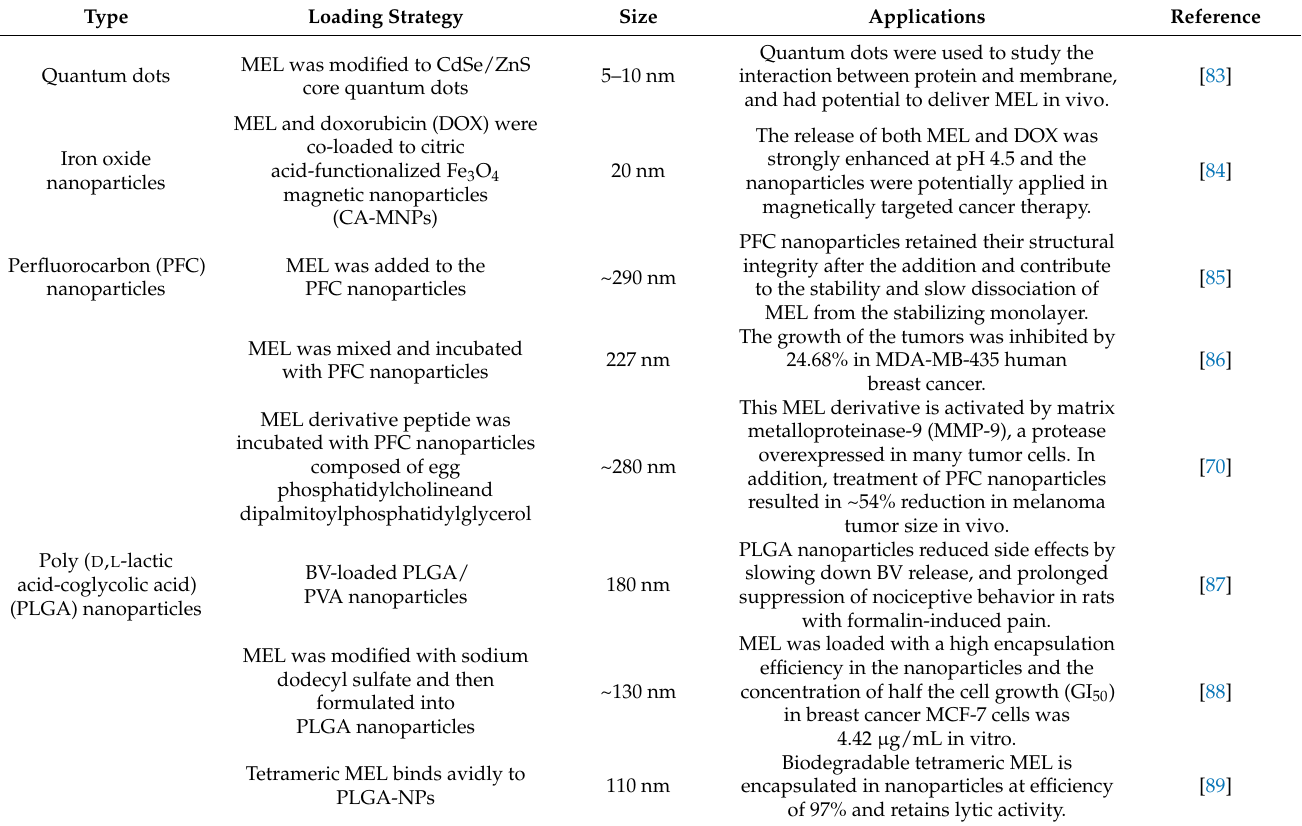
Table 3. Summary of MEL-loading nano-delivery systems and